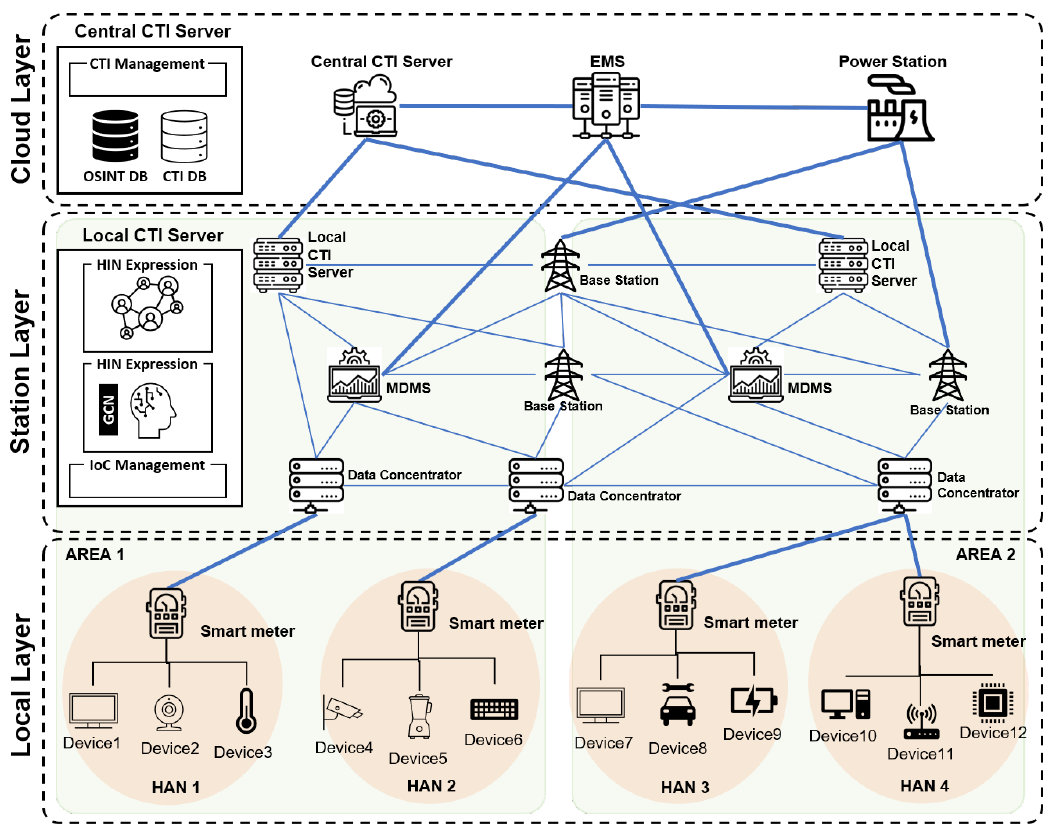
Figure 1. Architecture of the cyber threat intelligence framework for an energy cloud platform. HAN, Home Area